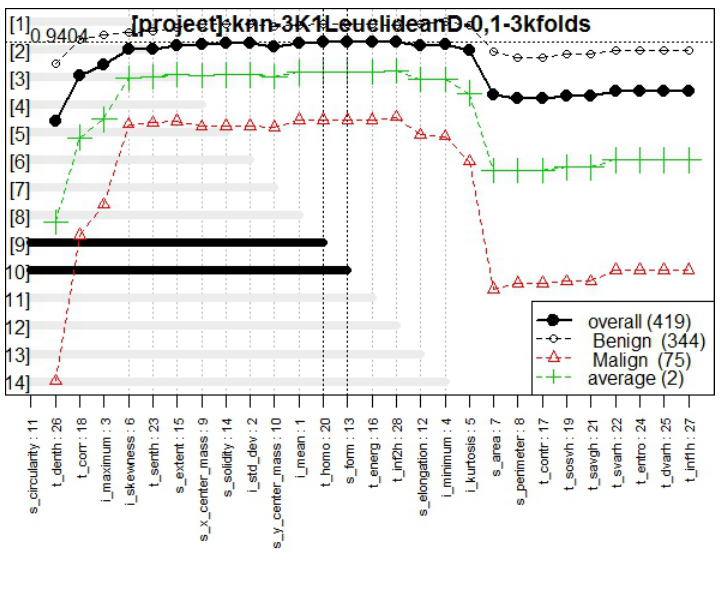
Figure 9. Genes behavior through Galgo algorithm with K-NN method.